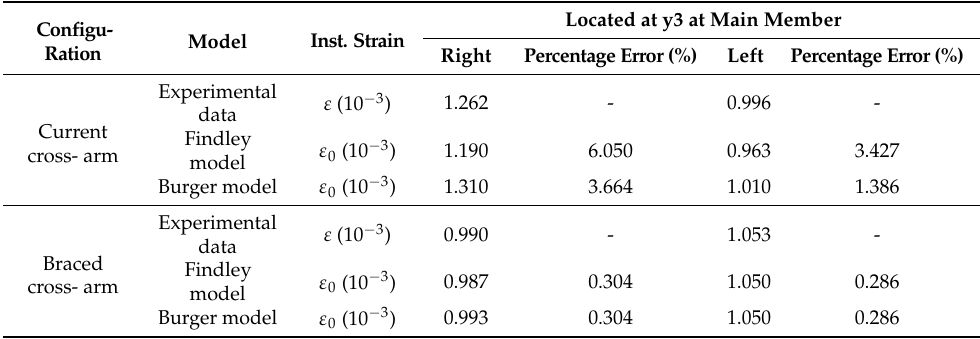
Table 4. Comparison of instantaneous strain value between experimental outputs and numerical models located at y3 in current and braced PGFRPC cross-arms. Located at y3 at Main Member Configu- Model Inst. Strain Ration Right Percentage Error (%) Left Percentage Error (%) Experimental ε (10 − 3 ) 1.262 - 0.996 - data Current Findley ε 0 (10 − 3 ) cross- arm model Burger model Experimental ε (10 − 3 ) 0.990 - 1.053 - data Braced Findley ε 0 (10 − 3 ) 0.987 cross- arm model Burger model ε 0 (10 − 3 )